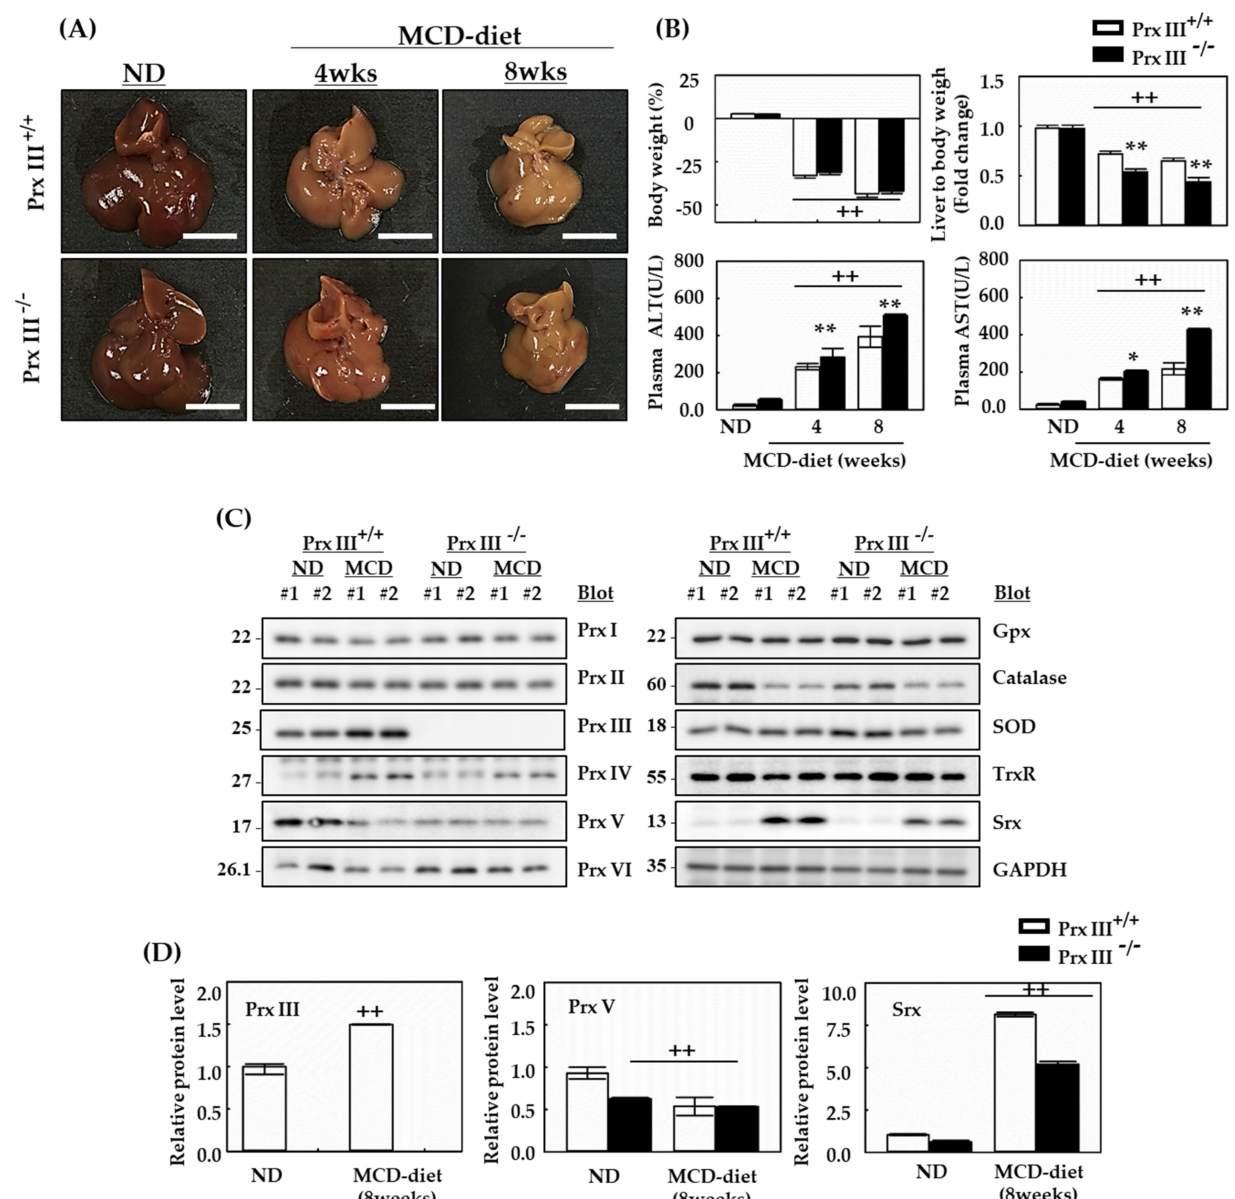
Figure 2. Antioxidant protein expression levels of Prx III +/+ and -/- mice fed the MCD diet. Mice fed the ND or MCD diet were sacrificed after 4 and 8 weeks. ( A ) When the MCD diet was applied for 8 weeks, the size of the liver progressively decreased with time. ( B ) Prx III +/+ and -/- mice fed the MCD diet were examined to determine body weight (%) and liver-to-bodyweight ratio. Liver injury was assessed by determining plasma levels of ALT and AST. Livers of Prx III +/+ and -/- male mice fed the MCD diet were extracted at 8 weeks. Proteins from homogenized liver tissue were analyzed by Western blotting. For statistical significance, five liver extracts of the same part in each individual were used for each group. ( C ) Expression levels of Prxs and other antioxidant proteins in the liver of Prx III +/+ and -/- mice. ( D ) Protein expression levels were normalized against GAPDH protein. Data are means ± SE from three independent experiments, with four to six mice per group. ++ p < 0.01 vs. control group mice fed ND, * p < 0.05, ** p < 0.01 vs. the MCD diet-fed Prx III +/+